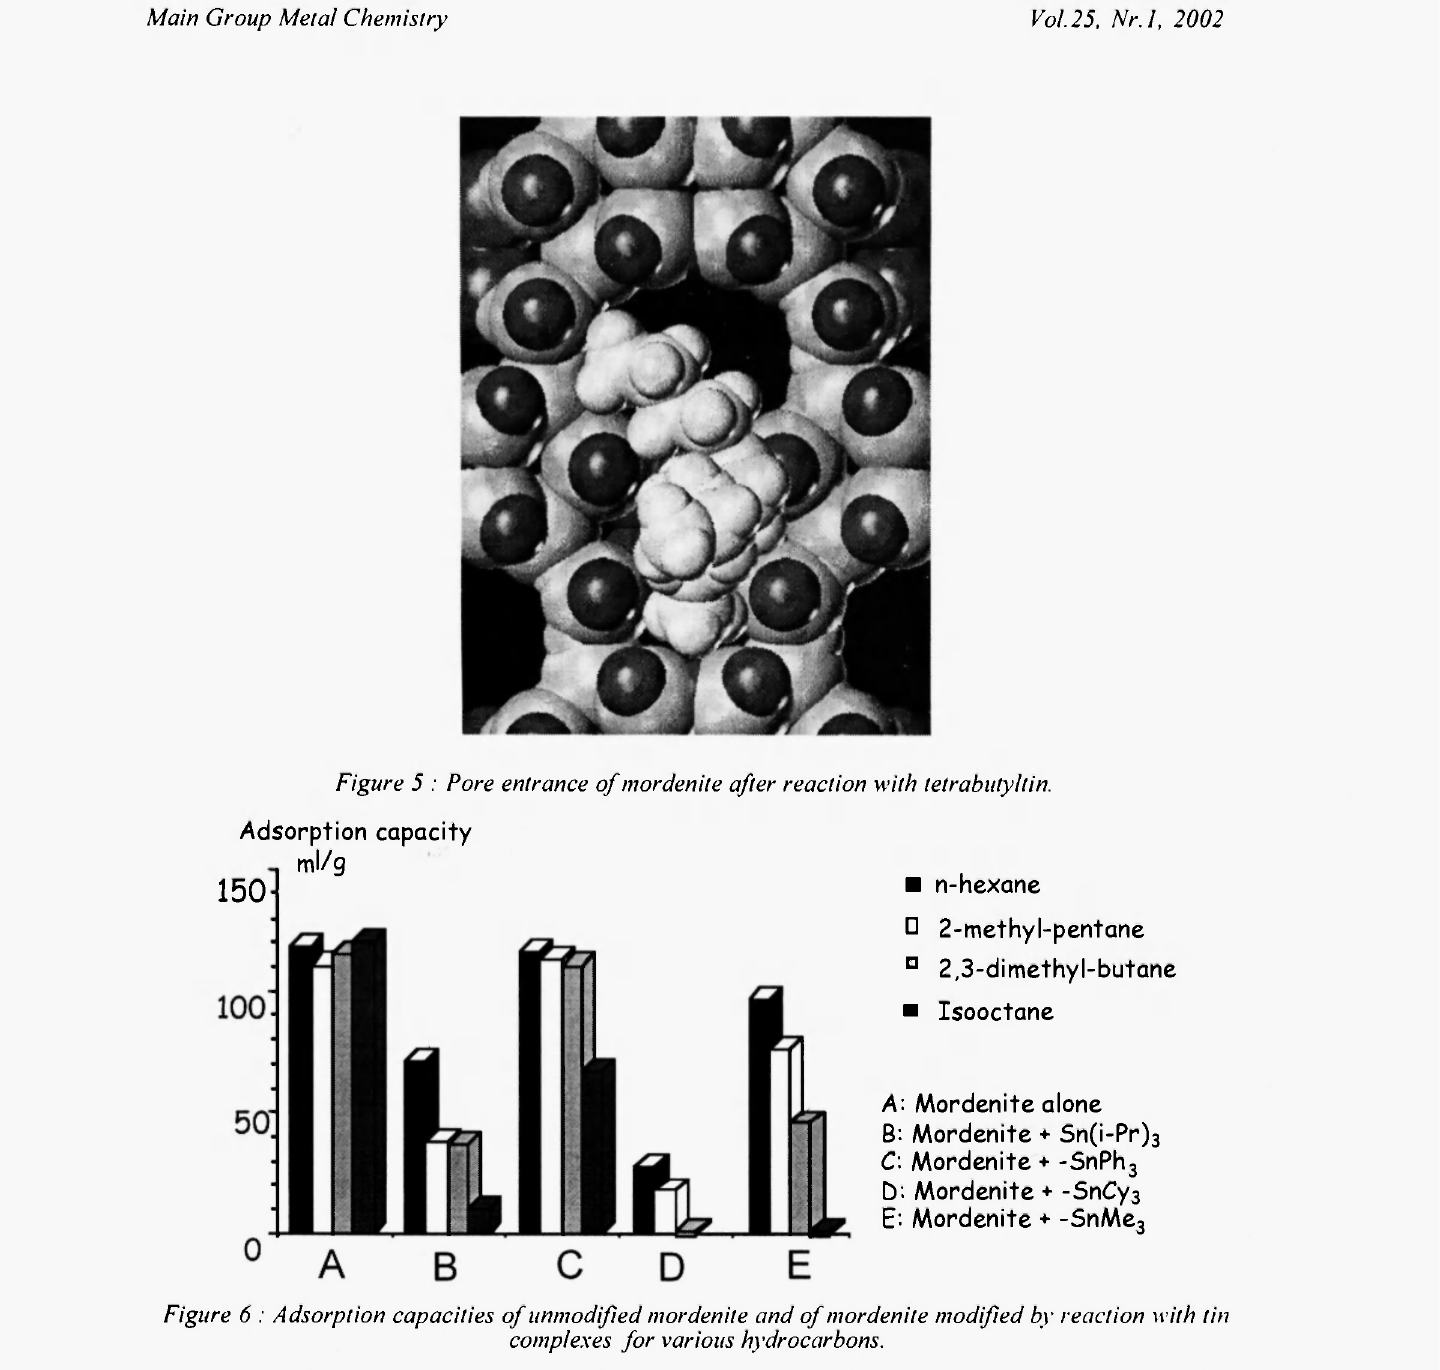
Figure 6 : Adsorption capacities of unmodified mordenite and of mordenite modified by reaction with tin complexes for various